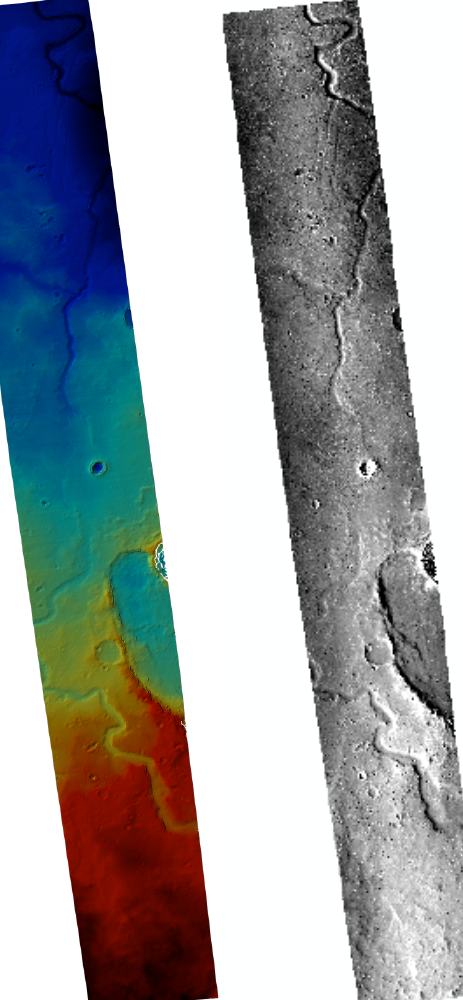
Figure 9. An example of one of the MC11-E CTX DTM and ORI products from CASP-GO